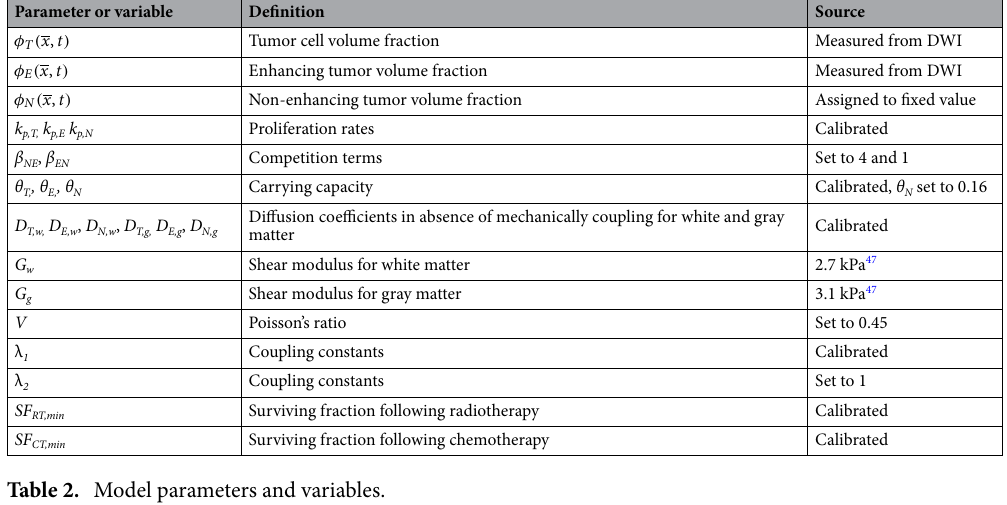
Table 2. Model parameters and